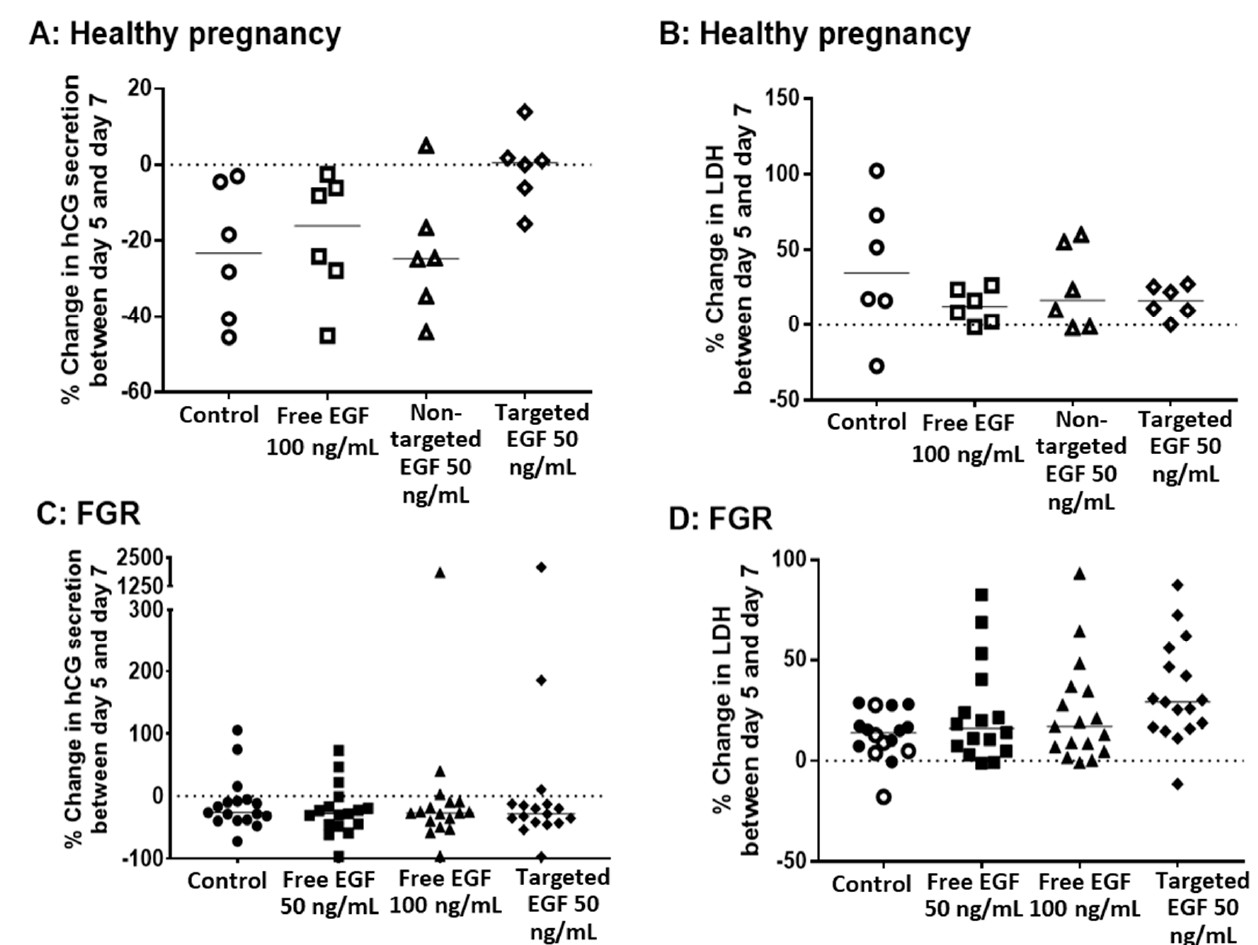
Figure 3. Targeted delivery of EGF does not alter placental secretion of hCG or release of LDH in healthy pregnancy or FGR. Healthy ( A , B ) and FGR ( C , D ) third-trimester human placental explants were cultured for 7 days and treated with either 10 µL PBS (control), free EGF (50 or 100 ng/mL), undecorated liposomes encapsulating 50 ng/mL EGF (non-targeted) or GPS-decorated liposomes encapsulating 50 ng/mL EGF (targeted) for 48 h on days 5–7. Percent change in hCG secretion ( A , C ) and LDH release ( B , D ) between day 5 and day 7, as measured by ELISA. n = 6 healthy pregnancy, n = 17 FGR. Data not significantly different. EGF = epidermal growth factor, FGR = fetal growth restriction, hCG = human chorionic gonadotropin, LDH = lactate dehydrogenase.